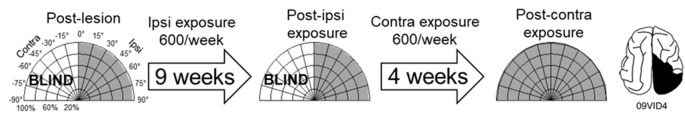
Multisensory training in the unaffected (ipsilesional) hemifield failed to induce recovery from hemianopia. Nine weeks of ipsilesional multisensory exposure at 45° (600 exposures/session) failed to ameliorate the animal’s hemianopia (conventions are the same as in Figure 4). At week 10 the cross-modal stimulus was moved to 45° in the blind (contralesional) hemifield. A series of exposures (600/session) at this location led to visual recovery within the same time frame as in animals that only had multisensory exposure in the blind hemifield.